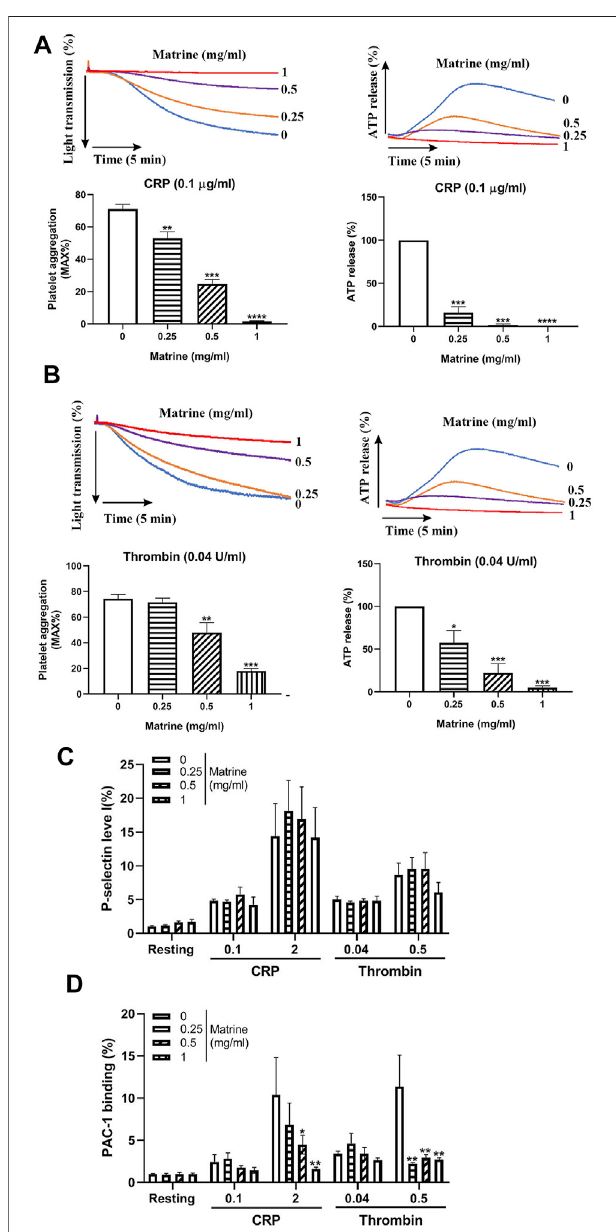
FIGURE 1 | Platelet aggregation and granules release. Washed human platelets were treated with different doses of matrine (0, 0.25, 0.5, and 1 mg/ ml) at 37 ° C for 1 h to measure platelet aggregation induced by CRP (0.1 μ g/ ml) (A) orthrombin(0.04 U/ml) (B) inaLumi-Aggregometer.Atthe same time, ATP release was monitored simultaneously using luciferin/luciferase reagent and presented as a relative to 0 mg/ml matrine which was de fi ned as 100%. After matrine treatment, platelet P-selectin expression ( α -granule) (C) and integrin α IIb β 3 activation (PAC-1 antibody binding) (D) was measured after collagen or thrombin stimulation using PE-conjugated anti-P-selectin antibody or FITC-conjugated PAC-1 antibody by fl ow cytometry. Data were presented as mean ± SE (n (cid:2) 3 – 5) and analyzed by one-way ANOVA. Compared to 0, * p < 0.05; ** p < 0.01; *** p <